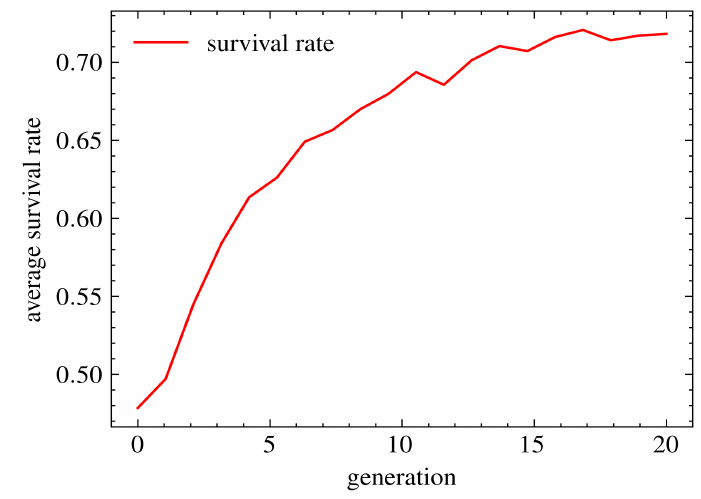
Figure 13. Survival rate between each